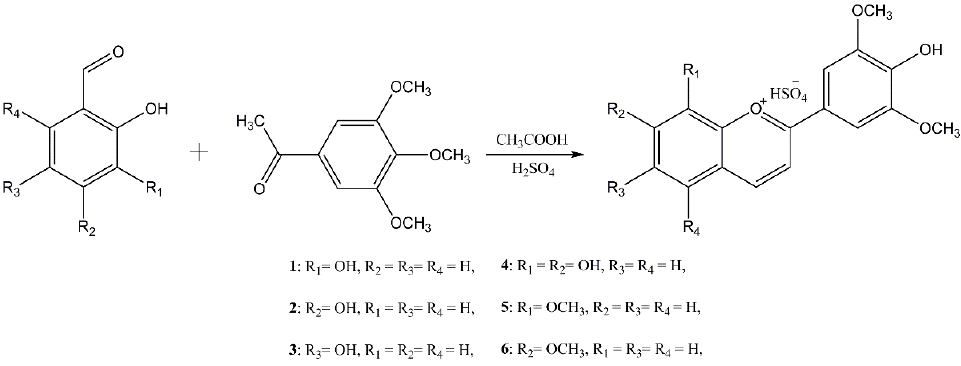
Table 5. Experimental absorption wavelengths and energies of the flavylium